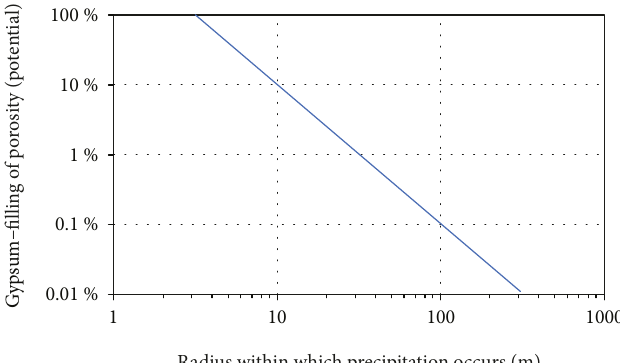
Figure 9: Percentage of pore space potentially fi lled by gypsum, assuming gypsum precipitation occurs entirely within a given radius of the injection well (assuming e ff ective porosity = 26%